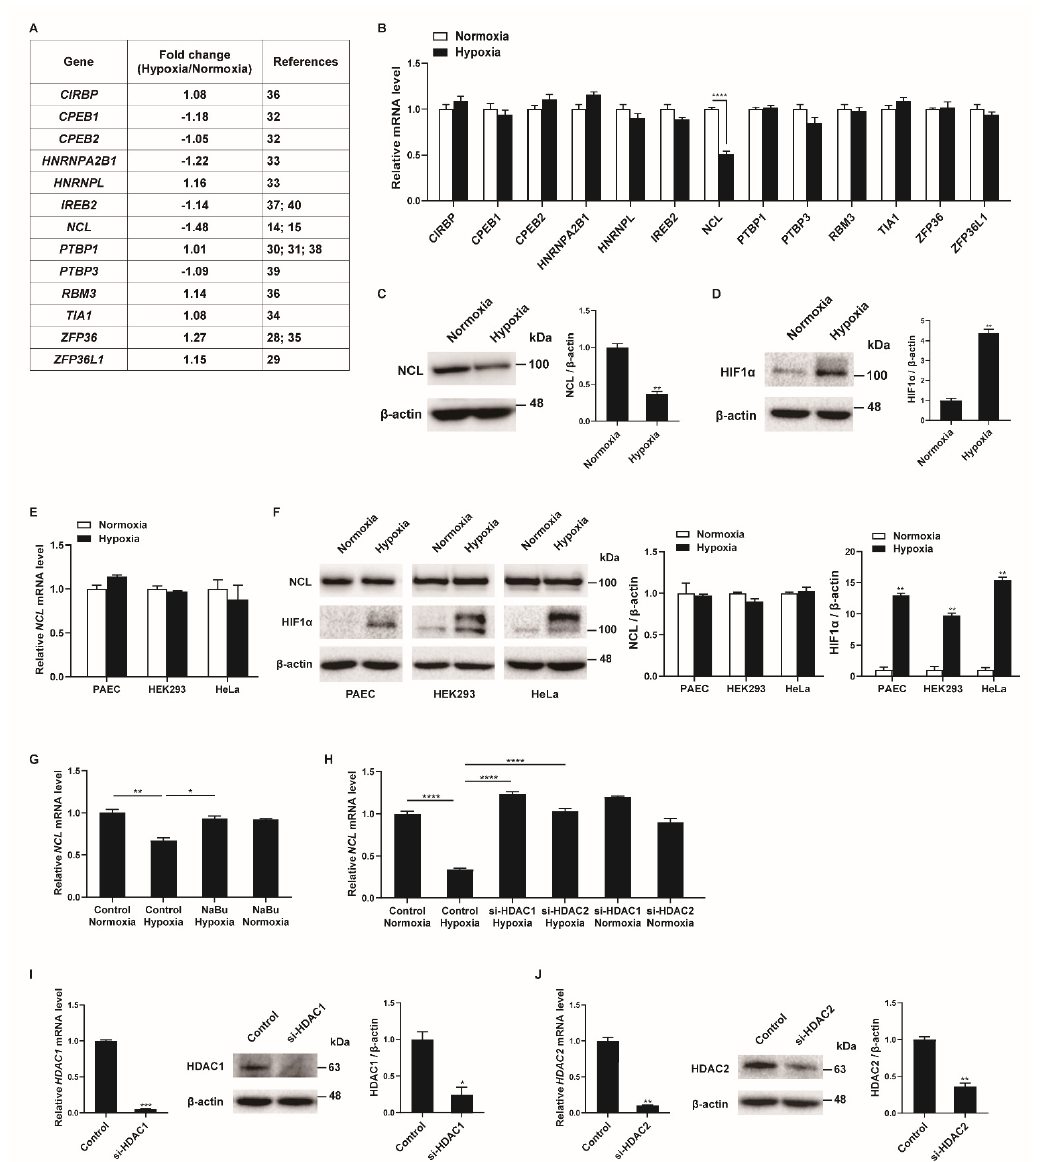
Figure 1. Hypoxia downregulates NCL in PASMCs. ( A ) Expression levels of RBPs were compared in PASMCs exposed to normoxia or hypoxia by NGS-based RNA sequencing from our previous study [27]. ( B ) Levels of the indicated mRNAs relative to 18S rRNA measured by qRT − PCR in PASMCs exposed to normoxia or hypoxia for 24 h. Data represent the mean ± S.E. of triplicate mea- surements of three independent experiments. ( C , D ) Immunoblot analysis of lysates from PASMCs exposed to normoxia or hypoxia for 24 h with anti − NCL, anti − HIF1 α , or anti- β − actin antibody. By densitometry, relative amounts of NCL ( C ) and HIF1 α ( D ) normalized to β − actin were quanti- tated. ( E ) Levels of NCL mRNAs relative to 18S rRNA measured by qRT − PCR in PAEC, HEK293, and HeLa exposed to normoxia or hypoxia for 24 h. Data represent the mean ± S.E. of triplicate measure- ments of three independent experiments. ( F ) Immunoblot analysis of lysates from PAEC, HEK293, and HeLa exposed to normoxia or hypoxia for 24 h using anti − NCL, anti − HIF1 α , or anti − β − actin antibodies. By densitometry, relative amounts of NCL or HIF1 α normalized to β − actin were quanti- tated. ( G ) Levels of NCL mRNAs relative to 18S rRNA measured by qRT − PCR in PASMCs treated with HDAC inhibitor NaBu under normoxia or hypoxia. ( H ) PASMCs were transfected with control or siRNAs against HDAC1 or HDAC2 for 24 h, followed by hypoxia exposure for 24 h. Levels of